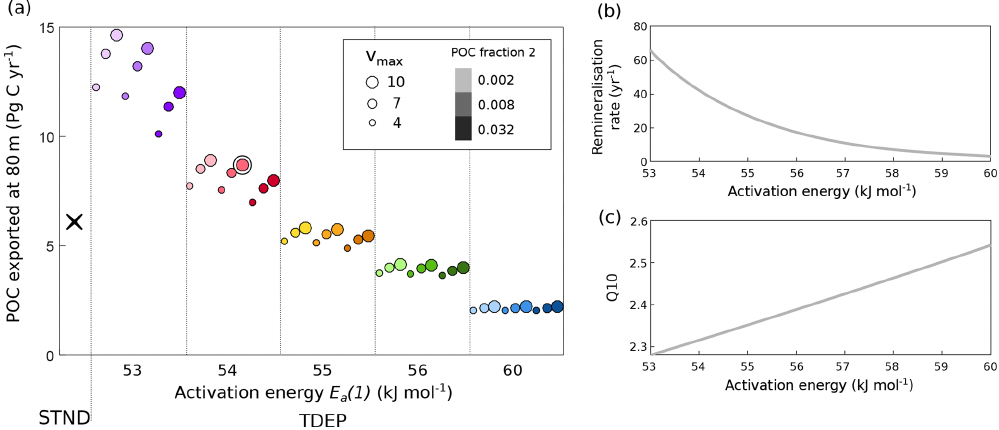
Figure 11. Global POC flux (PgCyr − 1 ) at 80m (a) and the effect of activation energy on (b) remineralisation rate and (c) Q 10 (for a 0 to 10 ◦ C change). In (a) the STND model is shown as a black cross, and the TDEP model is indicated by circles. The best-fit TDEP setting is double circled. STND is the standard model, and TDEP is the temperature-dependent model. Colours in (a) reflect those used in Fig.